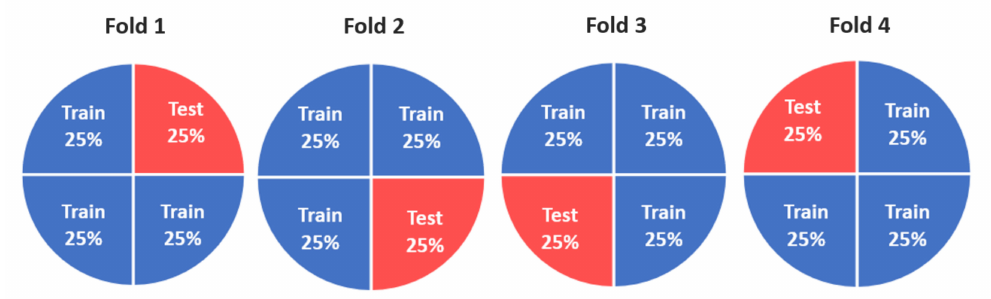
Figure 7. We used four-fold cross-validation (CV) for our wildfire inventory dataset. Each section represents a randomly selected fold of the inventory wildfire points. The sections with red color were used for testing, and those with blue color were used for training the ML